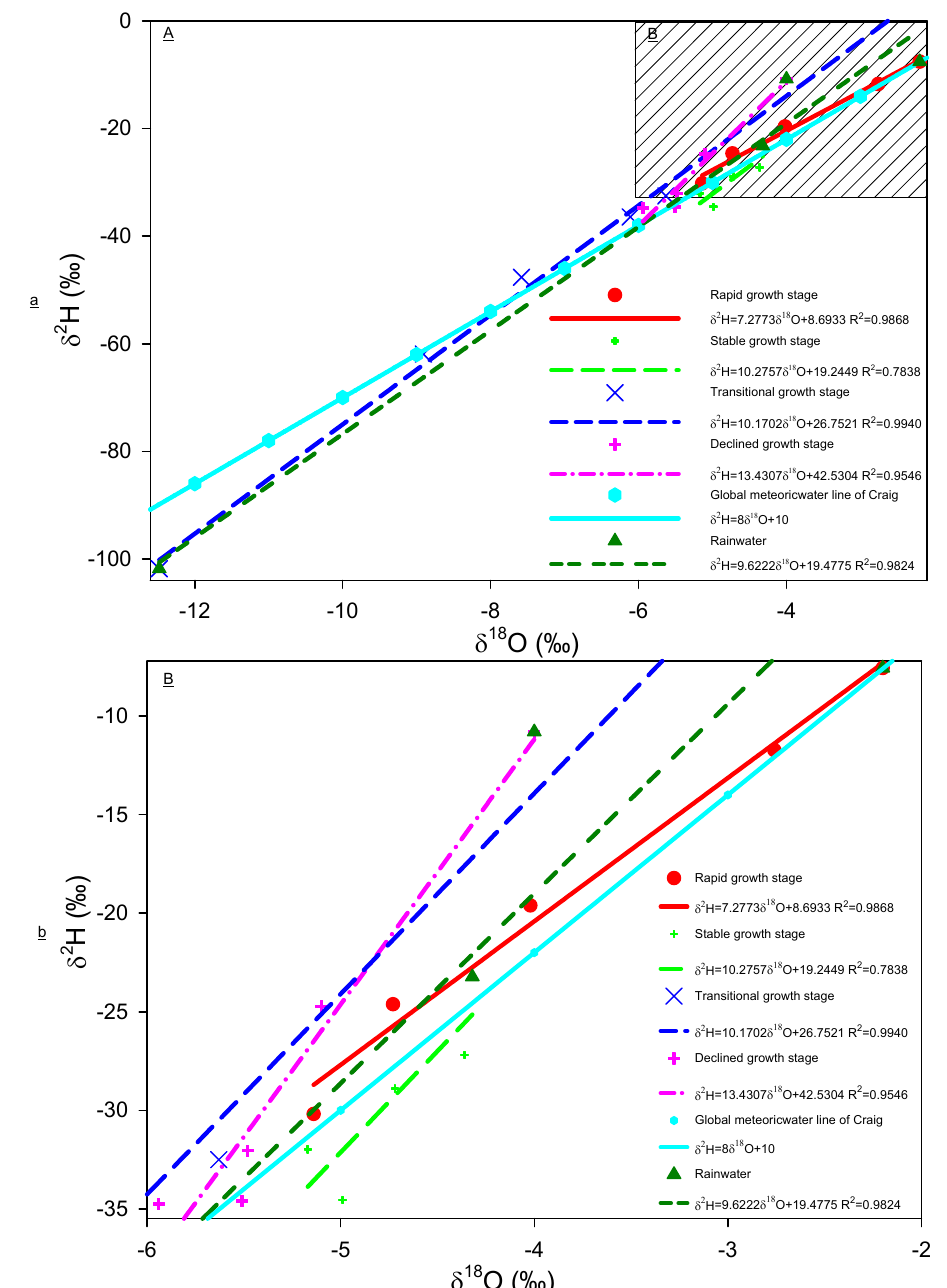
Figure 5. Isotope compositions of rainwater, shallow soil water, deep soil water, and Carex cinerascens stem water. Isotope compositions were calculated from the isotope composition from sampling sites. The lower part (b or B) of the figure is the same as the shaded part (B) of the upper part (a or A) of the figure. In the legend, each line is fitted by the points above it. In every stage, the points include the shallow soil water, the deep soil water, the groundwater, Carex cinerascens and rainwater. In rainwater, the points include isotope compositions of rainwater of all